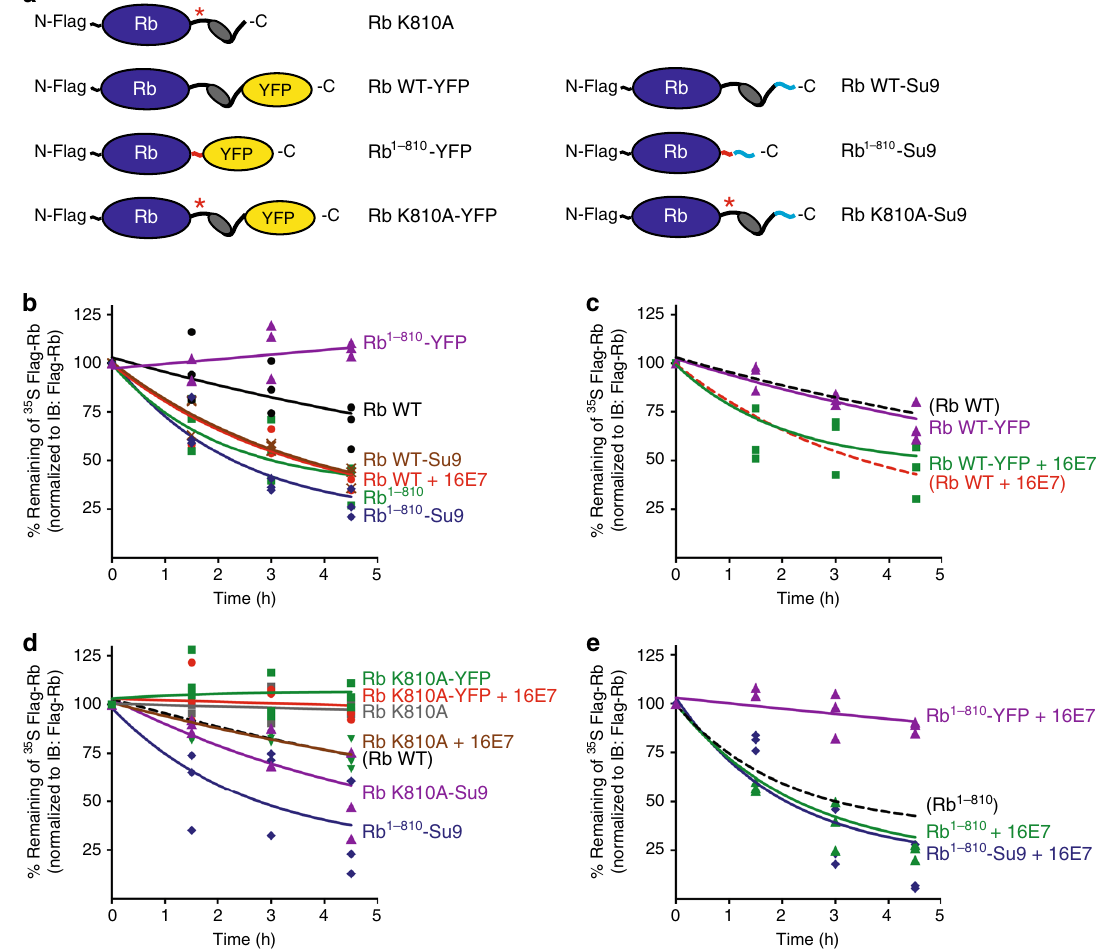
Fig. 2 The degradation of Rb is regulated by its C-terminus. a Schematic view of Rb WT, Rb 1 – 810 , and the cleavage-resistant mutant of Rb in which Lys 810 was replaced with Ala (Rb K810A), with either YFP or an Su9 tail attached at their C-termini. The K810A mutation site, YFP, and Su9 tail are highlighted in red with an asterisk, in yellow, and in light blue, respectively. b – e Metabolic pulse chase of Rb in cells. HEK293T cells were transfected with Rb mutants (see Fig. 1b and a of the fi gure) and empty vector or 16E7 for 42 h. The cells were metabolically labeled with [ 35 S] methionine/cysteine for the last 20 h, washed twice with PBS, and chased in label-free medium for the indicated times. Rb mutants were immunoprecipitated from the cell lysates and subjected to SDS-PAGE, followed by immunoblotting with Flag antibody and electronic autoradiography. The effects of modi fi cations at the Rb C-terminus ( b ), of 16E7 expression ( c , e ), and of the K810A mutation ( d ) on the degradation rates of Rb were evaluated. Degradation of Rb WT, Rb WT + 16E7, and Rb 1 – 810 were replotted in some panels with broken lines to help with comparisons. The graphs plot the relative band intensities over time as a percentage of the initial protein amount from three repeat experiments. Representative gel images are shown in Supplementary Fig. 1a. Source data are provided as a Source Data fi